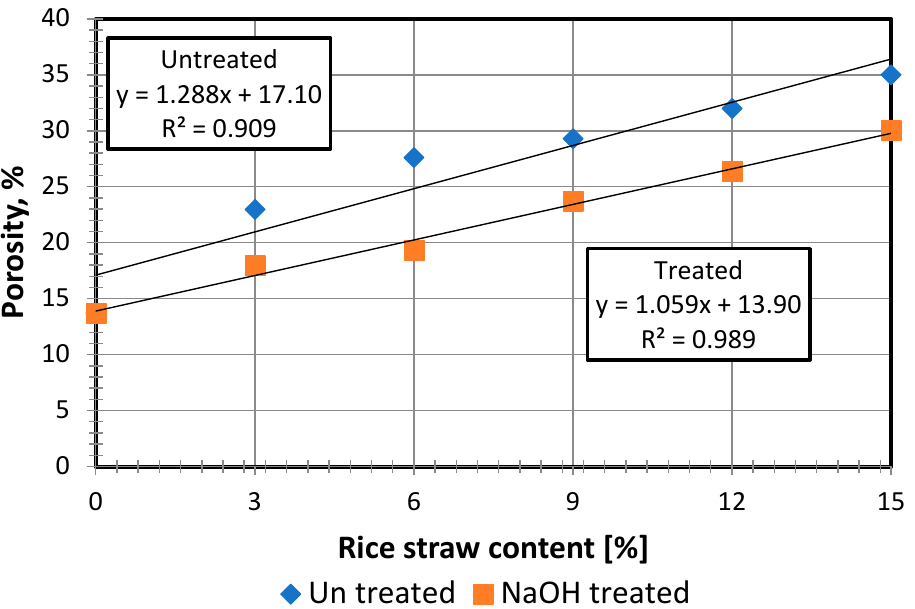
Figure 6. Porosity of the treated and untreated rice straw concrete at different rice straw contents.